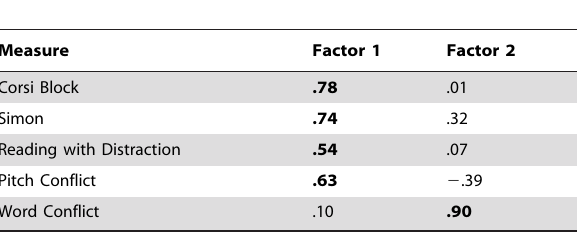
Table 3. Factor loadings from principal component